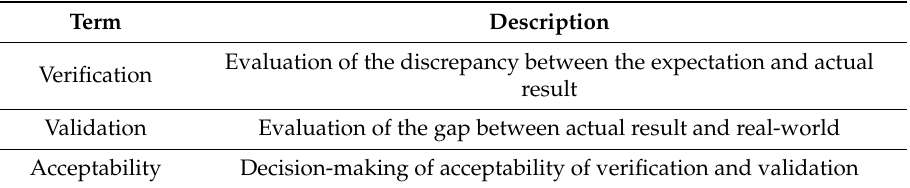
Table 9. Verification, validation and